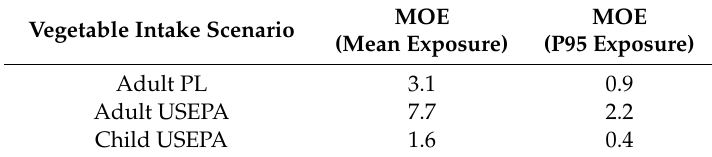
Figure 4. Carcinogenic risk (CR) values for As caused by vegetable ingestion. Table 5. Margin of exposure (MOE) values for Pb caused by vegetable